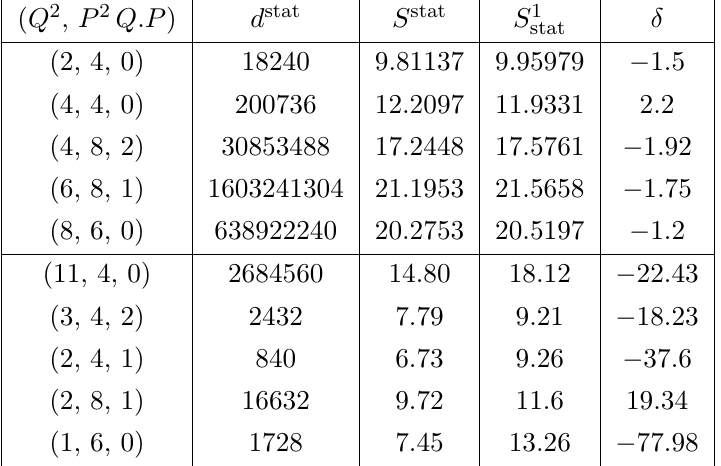
Table 20 . Comparison of the statistical entropy and the statistical entropy at one loop for the toroidal Z 2